Question: Author a descriptive caption for the visualization shown.
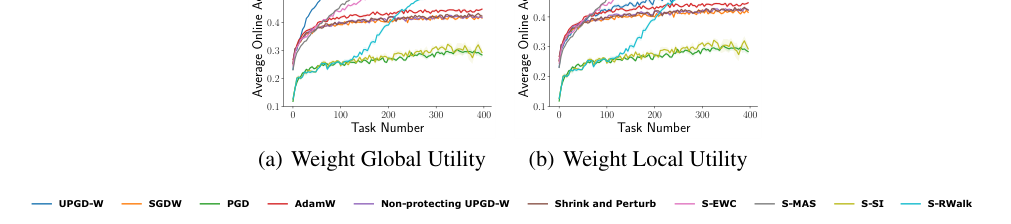
Answer: Performance of methods on Label-permuted CIFAR-10. First-order utility traces are used for UPGD and Non-protecting UPGD. Results are averaged over 10 runs.